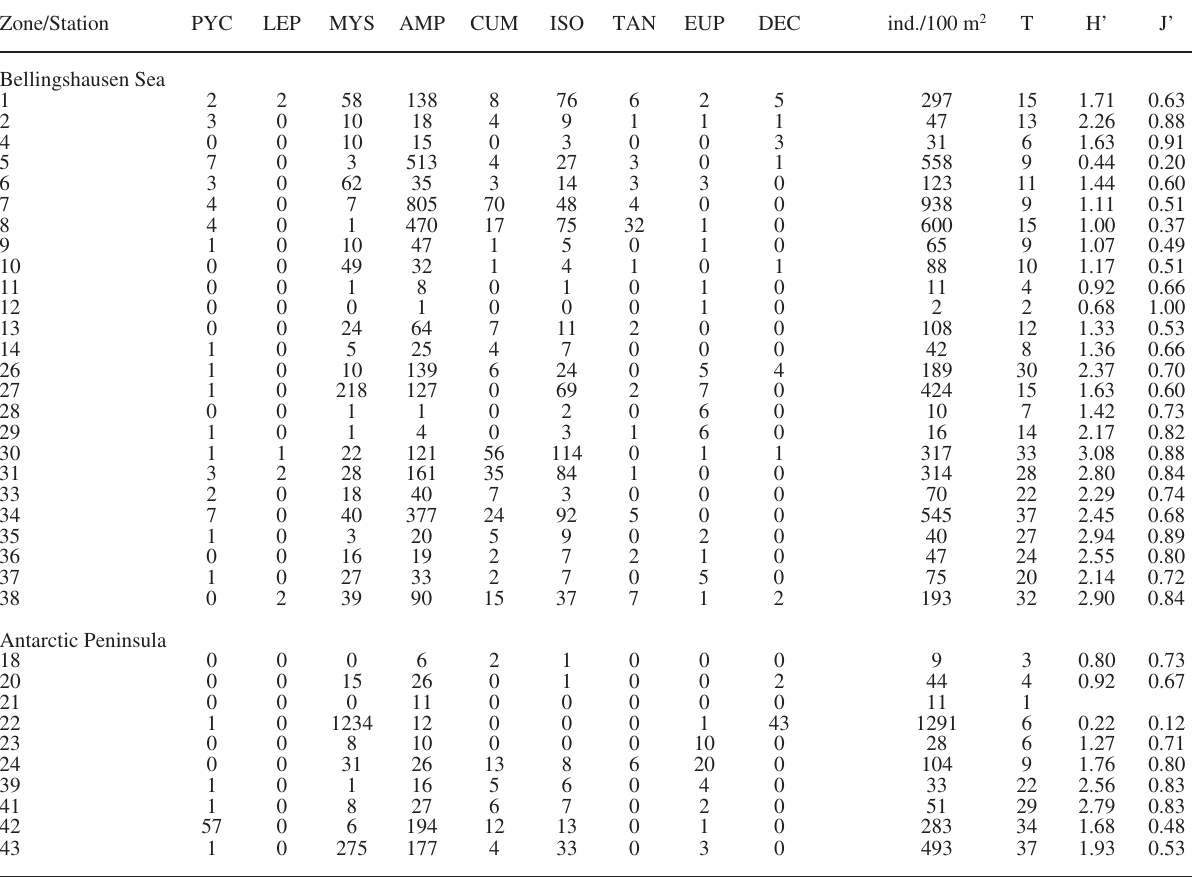
Table 3. – abundance (ind./100 m 2 ) of the major taxonomical groups, taxa richness (t), shannon-Wiener diversity (H’, log evenness index (J’) of the suprabenthic fauna sampled in the 10-140 cm near-bottom water layer. PYC, Pycnogonida; leP, leptostraca, mYs, mysida and lophogastrida; amP, amphipoda; Cum, Cumacea; iso, isopoda; tan, tanaidacea; euP, euphausiacea; deC, decapoda.